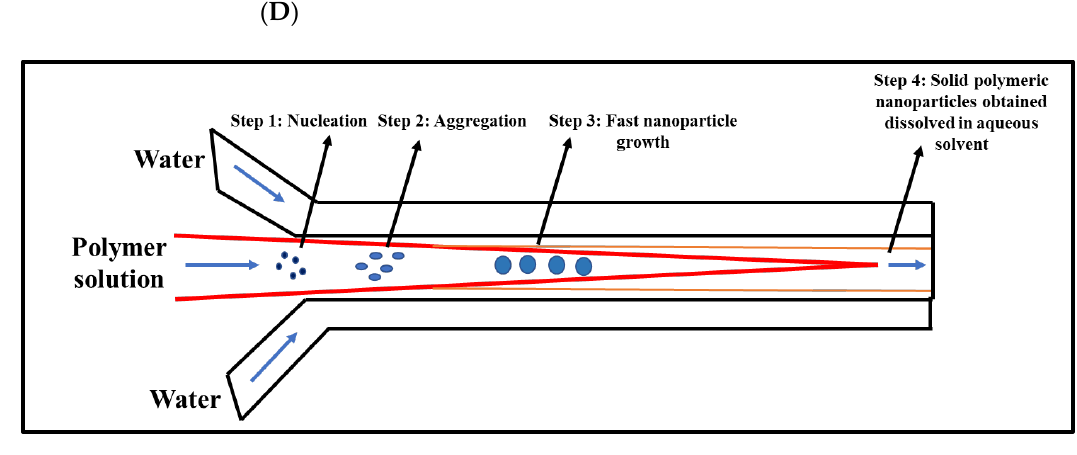
Figure 9. Schematic representation of various methods for biopolymeric nanoparticle fabrication. ( A ) Emulsification, ( B ) phase drying/coacervation, ( C ) spray drying, ( D ) desolvation, ( E ) microflu- idics.